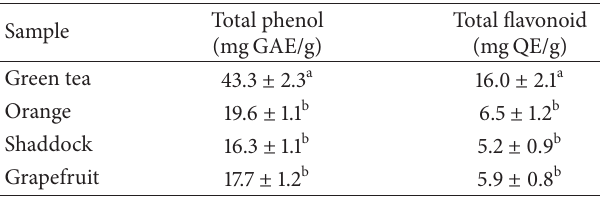
Figure 4: ABTS ∗ scavenging ability of infusions of green tea and some citrus peels. Table 1: Total phenolic and flavonoid contents of infusions of green tea and some citrus